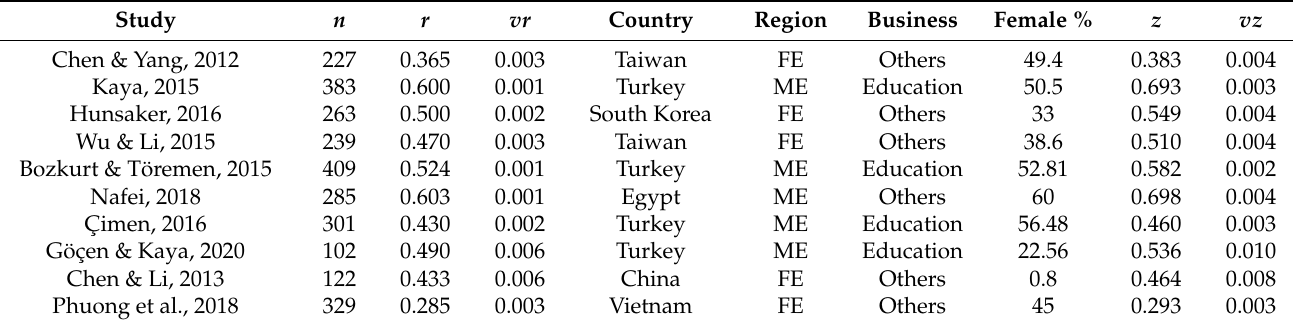
Table 1. Sample Dataset for Correlation and Moderator Analyses [48].